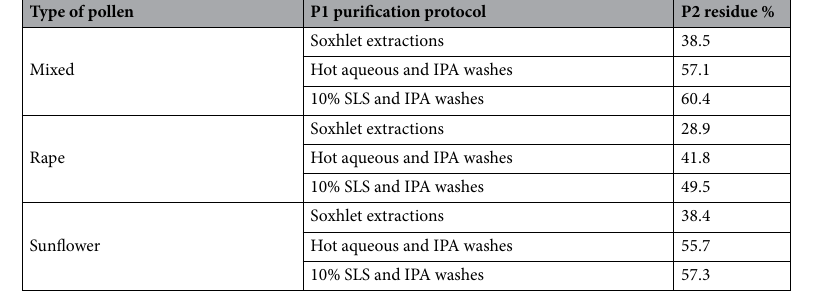
Table 4. Average ratio of the dry matter content of bee pollen samples P1-purified by different methods, before and after enzymatic P2 purification (removal of the intine wall and the cellular debris). Results of four experiments were averaged. The results are corrected with the losses occurring during the purification procedure. Losses were estimated by applying a similar purification protocol without using enzymes.